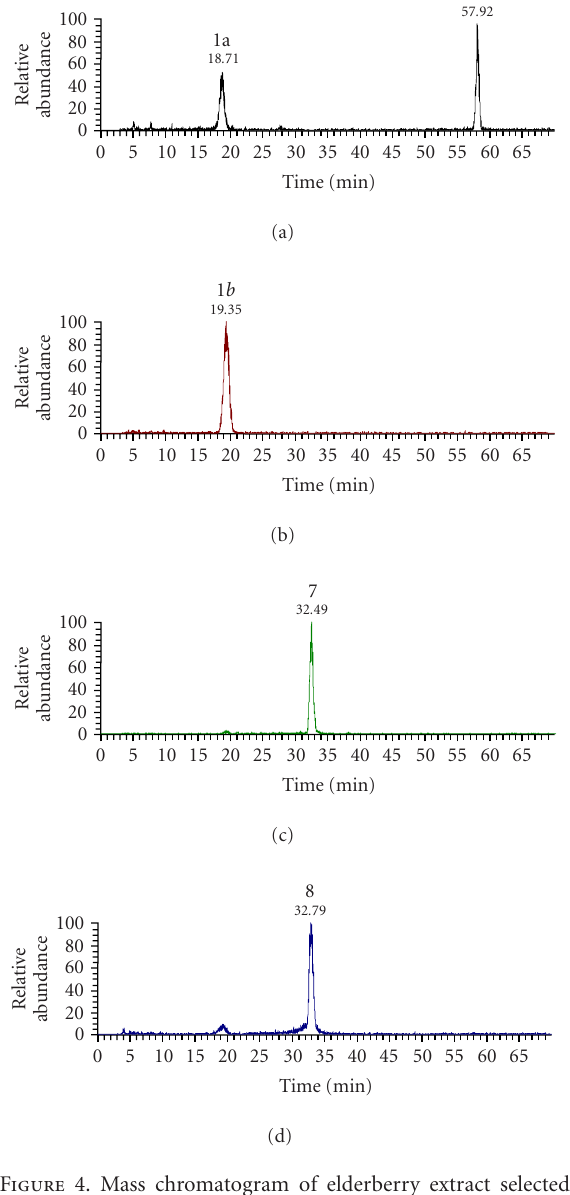
Figure 4. Mass chromatogram of elderberry extract selected by m/z of each anthocyanin. Mass chromatogram revealed that elderberry extract contains 4 anthocyanins; nevertheless, the extract showed only 2 peaks on PDA. The peaks of 1 and 7 in Figure 2 overlap with 1a and 1b, and 7 and 8, respec- tively. (a) Cyanidin 3,5-diglucoside ( m/z = 611); (b) cyani- din 3-sambubioside-5-glucoside ( m/z = 743); (c) cyanidin 3- sambubioside ( m/z = 581); (d) cyanidin 3-glucoside ( m/z = 449).